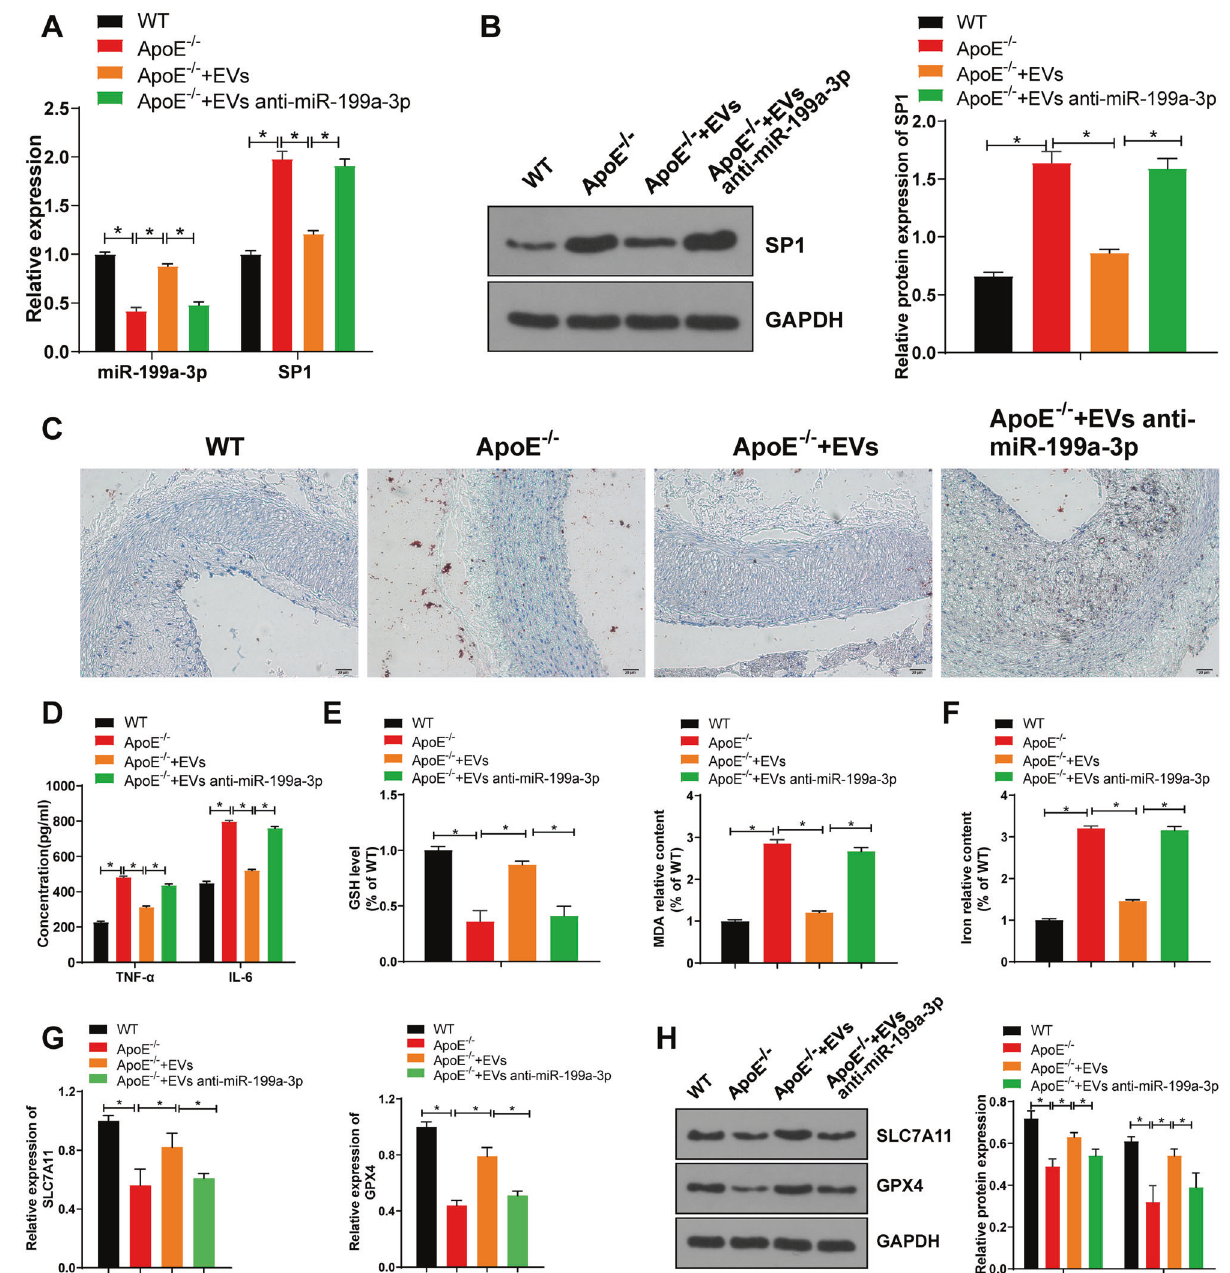
Fig. 6 EVs miR-199a-3p inhibited ferroptosis of ECs and thereby retarded atherosclerosis. ApoE-/- mice were given a high-fat diet (HFD) for 4 weeks, and then the HFD-fed ApoE-/- mice were injected with EVs or not. A The expressions of miR-199a-3p and SP1 in the aorta of atherosclerotic mice were detected using qRT-PCR. B SP1 expression in the aorta of atherosclerotic mice was detected using western blot. C The area of aortic root plaque was observed by oil red O staining (scale bar = 20 μ m). D The levels of in fl ammatory factors in serum of mice in each group were detected using ELISA. E GSH and MDA in the aorta of atherosclerotic mice were detected. F The iron content in aorta of atherosclerotic mice was detected. G , H SLC7A11 and GPX4 mRNA expression and protein levels in aorta of atherosclerotic mice were detected. N = 10. Measurement data are depicted as mean ± SD. The t test was used for the comparisons between two groups. One-way ANOVA was employed for the comparisons among multiple groups, followed by Tukey ’ s multiple comparisons test. * p <